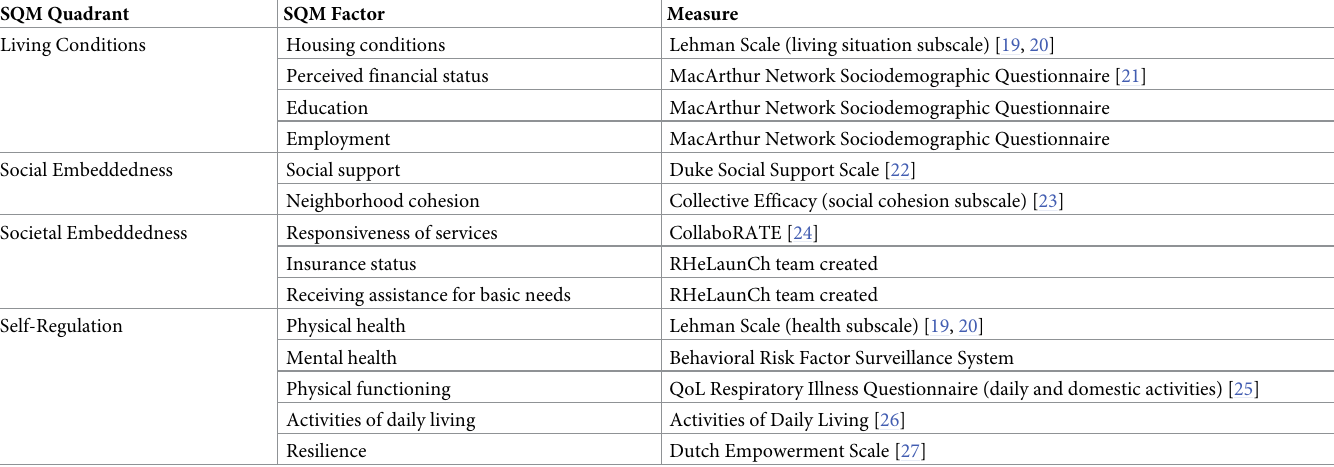
Table 1. Measures adapted to assess each factor within the social quality